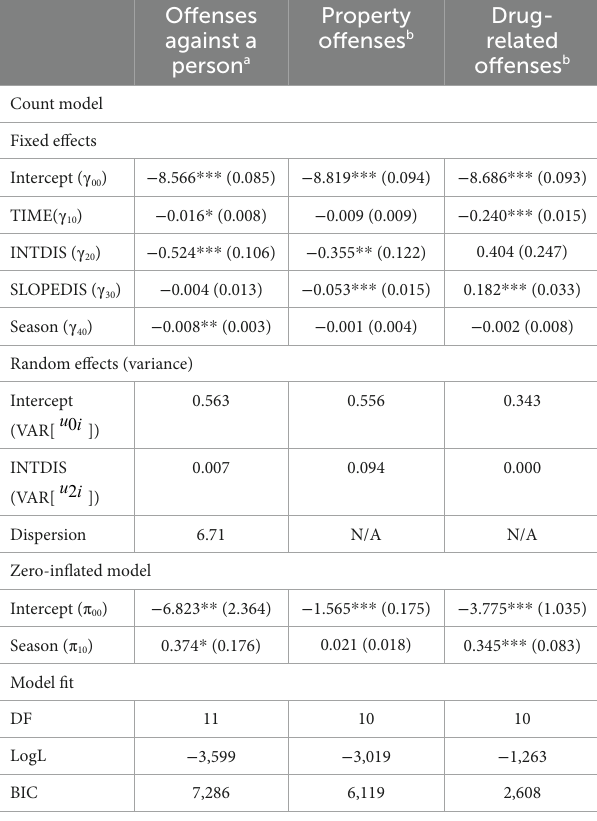
TABLE 4 Unconditional discontinuous growth models for the three types of delinquency.